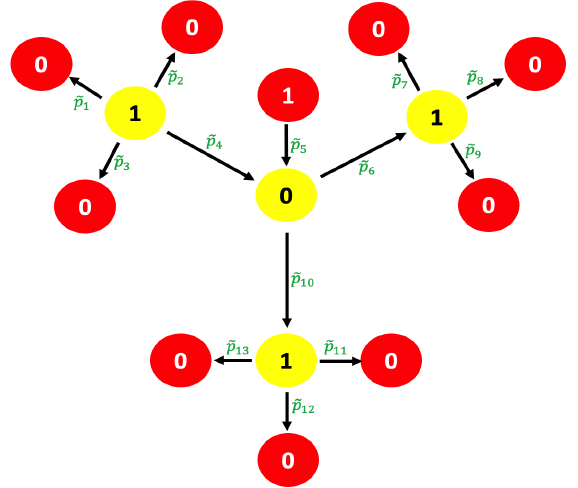
Figure 7. Isobutane compound graph with edge length | ˜ p τ | = 1 and vertices 0 or